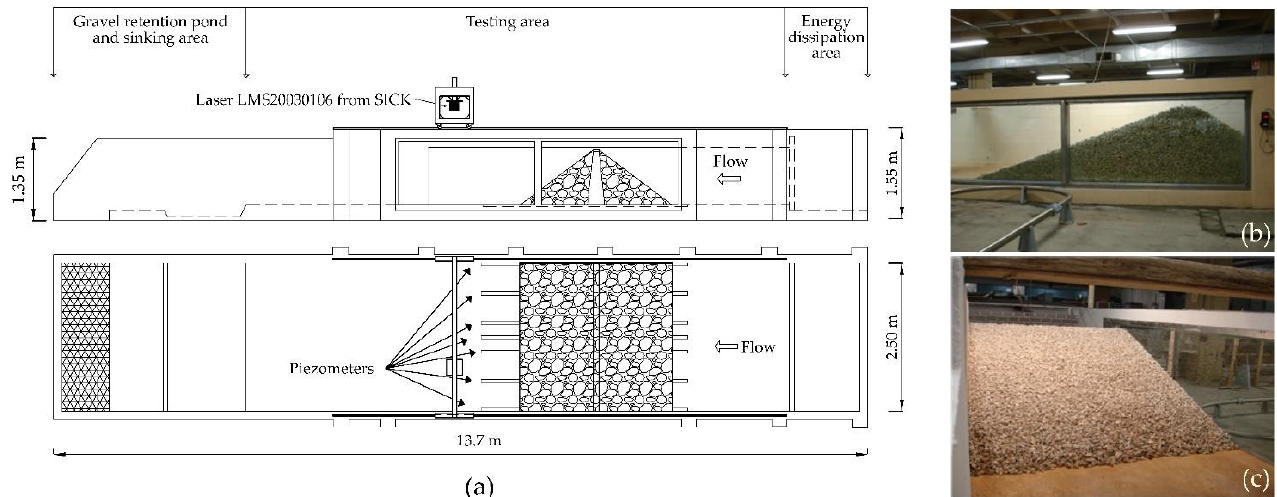
Figure 4. The UPM flume. ( a ) Scheme of the flume dimensions and areas, ( b ) image of a test taken from the outside of the flume through the inspection window located on the left-side wall, and ( c ) taken from inside the flume.